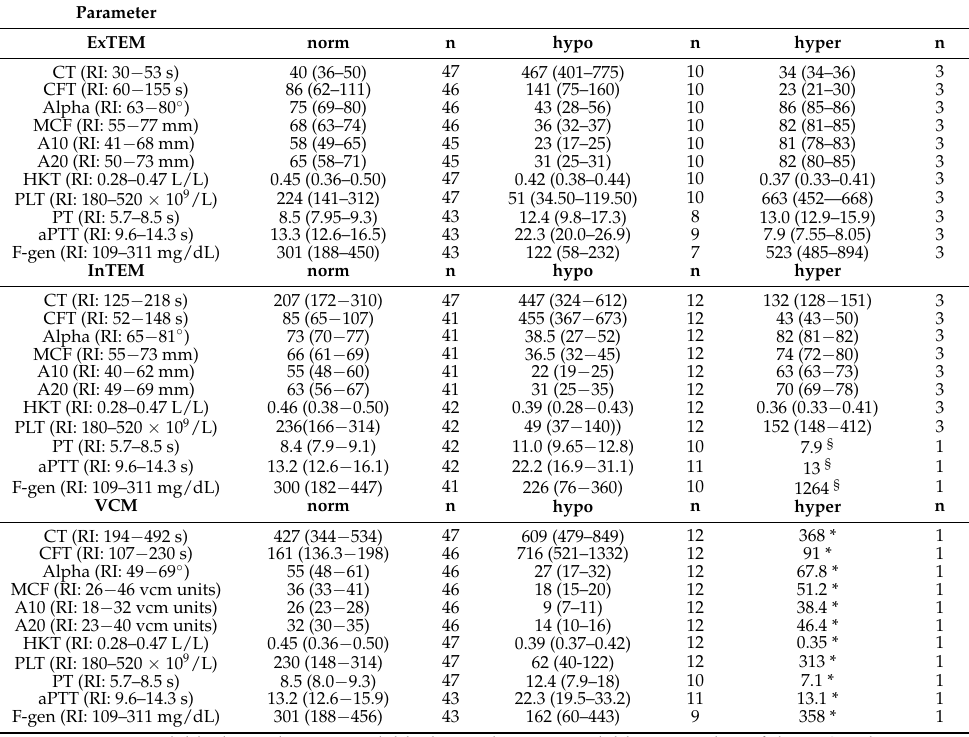
Table A2. Median (interquartile range) of ROTEM (ExTEM and InTEM), VCM and laboratory parameters in all dogs classified in normo-, hypo-, and hypercoagulable.